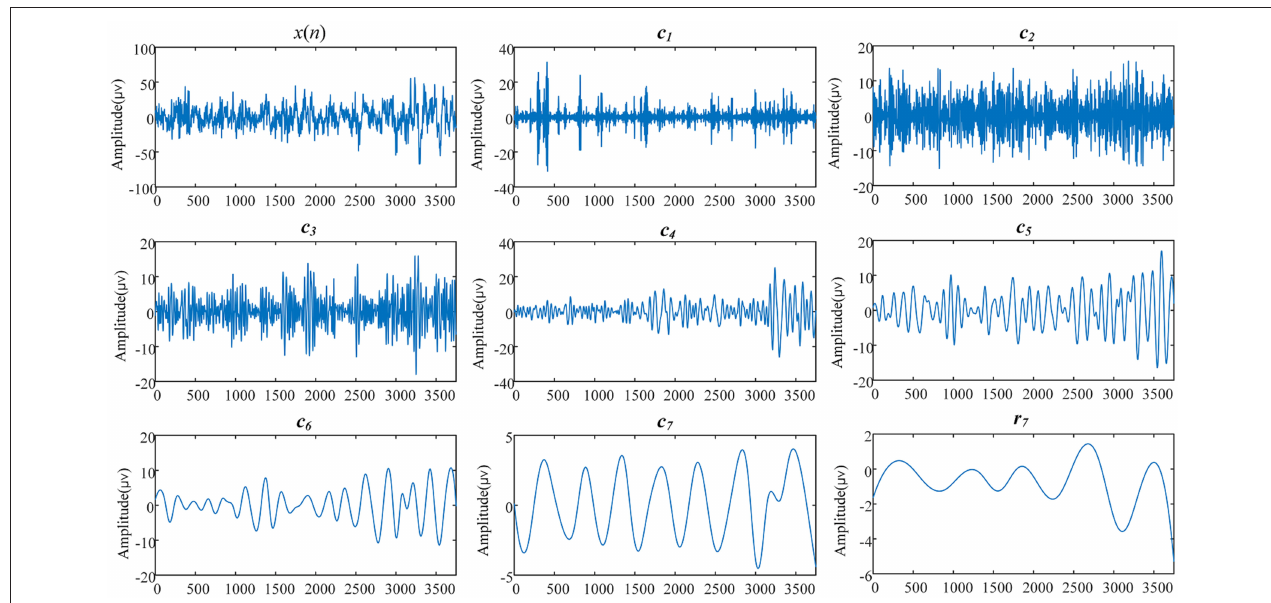
FIGURE 2 | The EEMD results of a 30s EEG signal derived from a 69-years-old woman (subject ID in SHHS-1 is 200301). x ( n ) is the original EEG signal, c i ( i = 1,2,…,7) are the IMFs, and r 7 is the residual part of data x ( n ) after 7 IMFs were extracted.